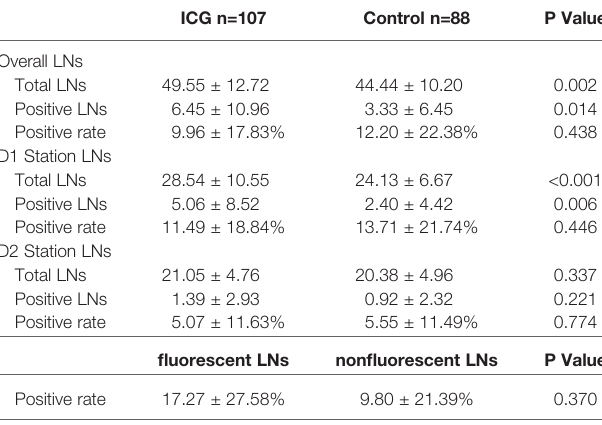
TABLE 4 | Number of retrieved lymph nodes in the ICG and control groups & Positive rate in the ICG group of fl uorescent and non fl uorescent LNs. ICG n=107 Control n=88